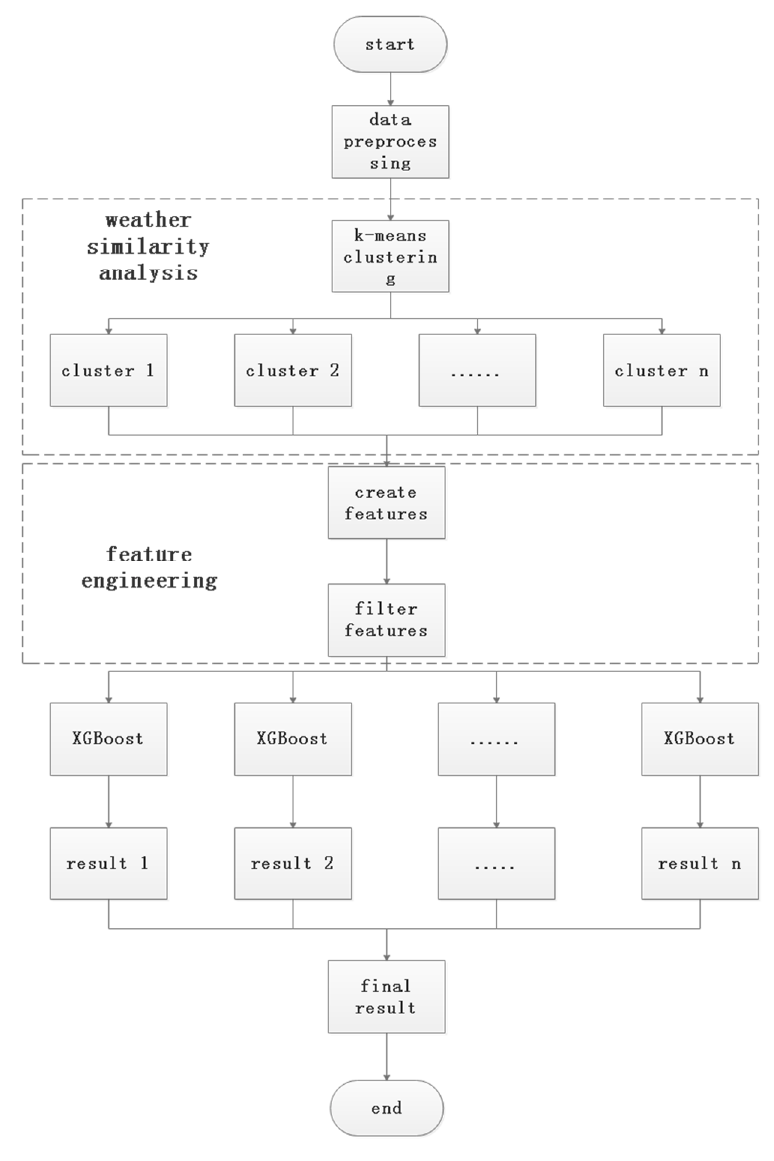
Figure 3. The structure of our model.